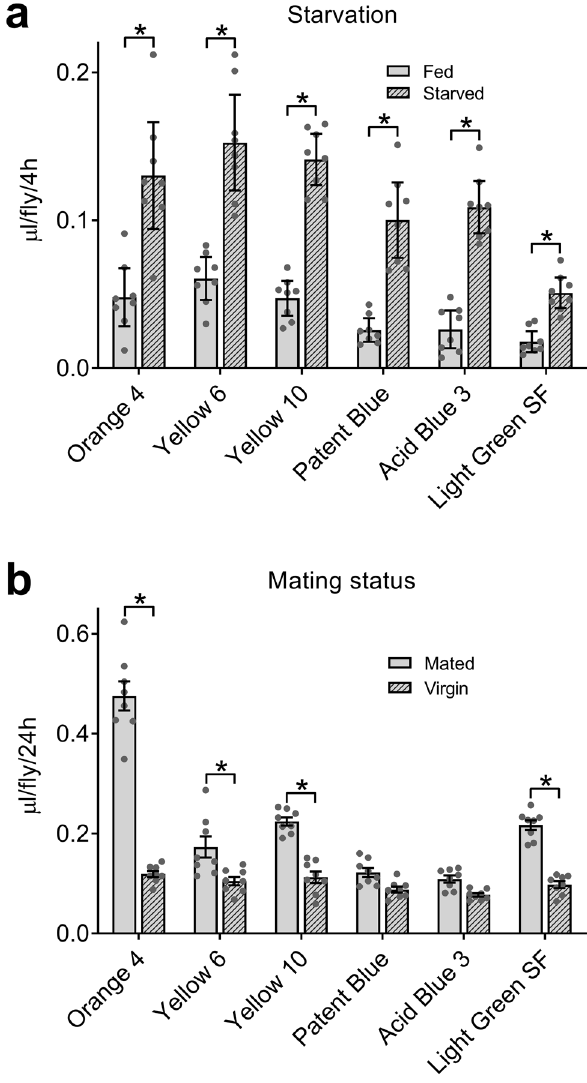
Figure 2. Six lead dyes in Con-Ex: response to starvation and mating status. ( a ) ExVial after refeeding for 4 h measured with all six dyes (1% w/v) in 2Y10S3C media increased significantly in GL females after 18 h of starvation and was affected by the dye used (two-way ANOVA; starvation, p < 0.0001; dye, p < 0.0001; interaction, p = 0.0058; n = 8). ExVial measured with all six dyes was greater in starved compared to fully fed flies (Bonferroni’s, p = 0.0405 to < 0.0001). ( b ) Mating status and the dye (1% w/v) used affected 24 h ExVial in GL females provided with 2Y10S3C media (two-way ANOVA; mating, p < 0.0001; dye, p < 0.0001; interaction, p < 0.0001; n = 8). Mated females had greater ExVial than virgin females when measured with Orange 4, Yellow 6 and Light Green SF (*Bonferroni’s, p = 0.0017 to < 0.0001), but not with Patent Blue (p = 0.3412) or Acid Blue 3 (p =